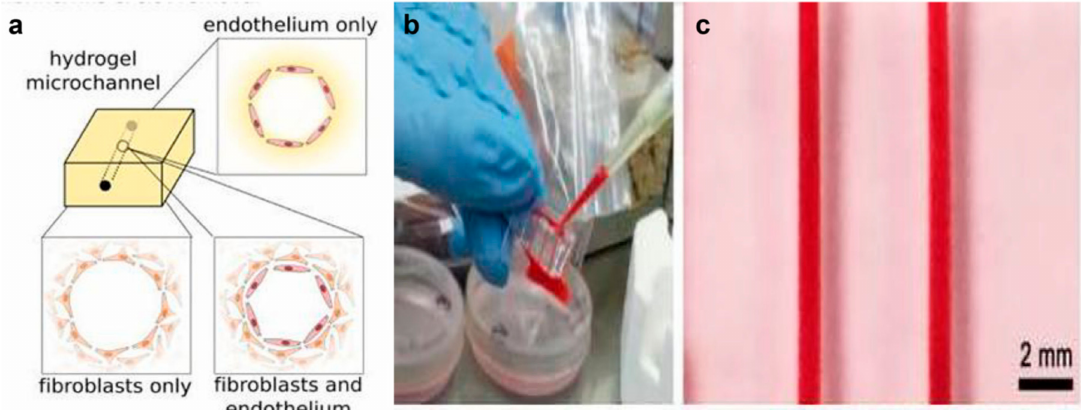
Figure 5. ( a ) To model the di ff erent aspects of thrombosis and fibrosis, three di ff erent types of models were generated: endothelium covering the microchannel wall with no encapsulated fibroblasts in the matrix (control), encapsulated fibroblasts with no endothelial cells covering the microchannel, and both encapsulated fibroblasts in the matrix and endothelium covering the microchannel. ( b ) Photographs showing the infusion of human whole blood into the endothelialized microchannels and ( c ) the formed thrombosis-on-chip model. Reproduced with permission